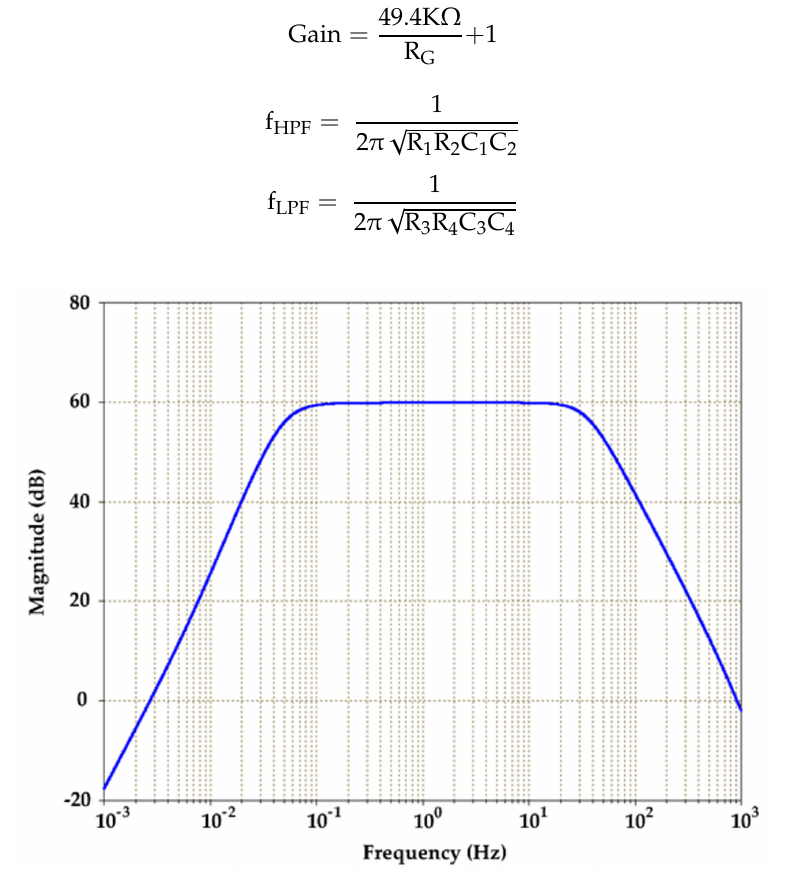
Figure 5. The simulated frequency response of the